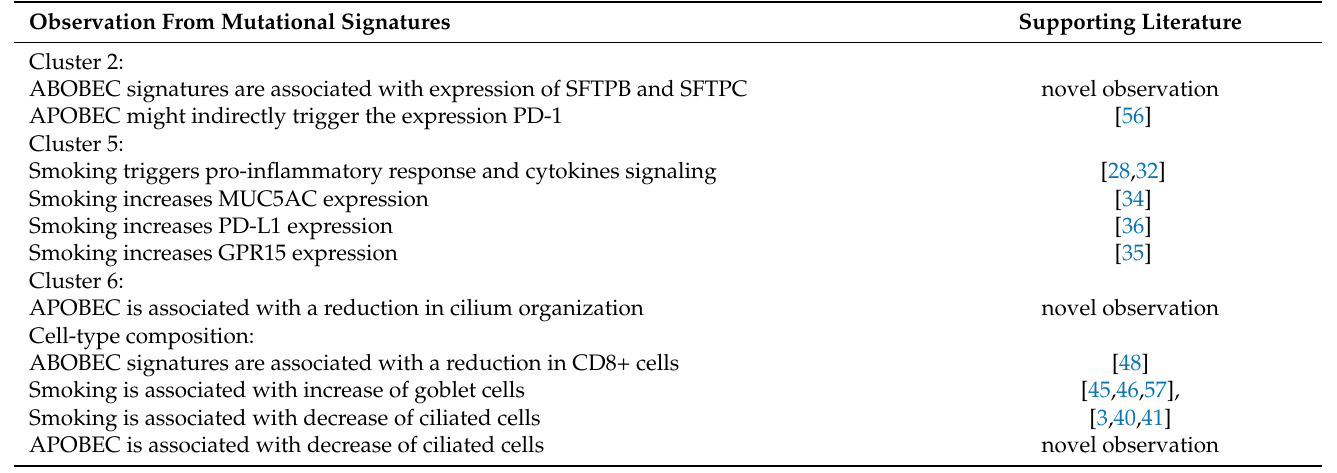
Table 1. Results of the analysis of the relation between mutational signatures and gene expression in the context of previous